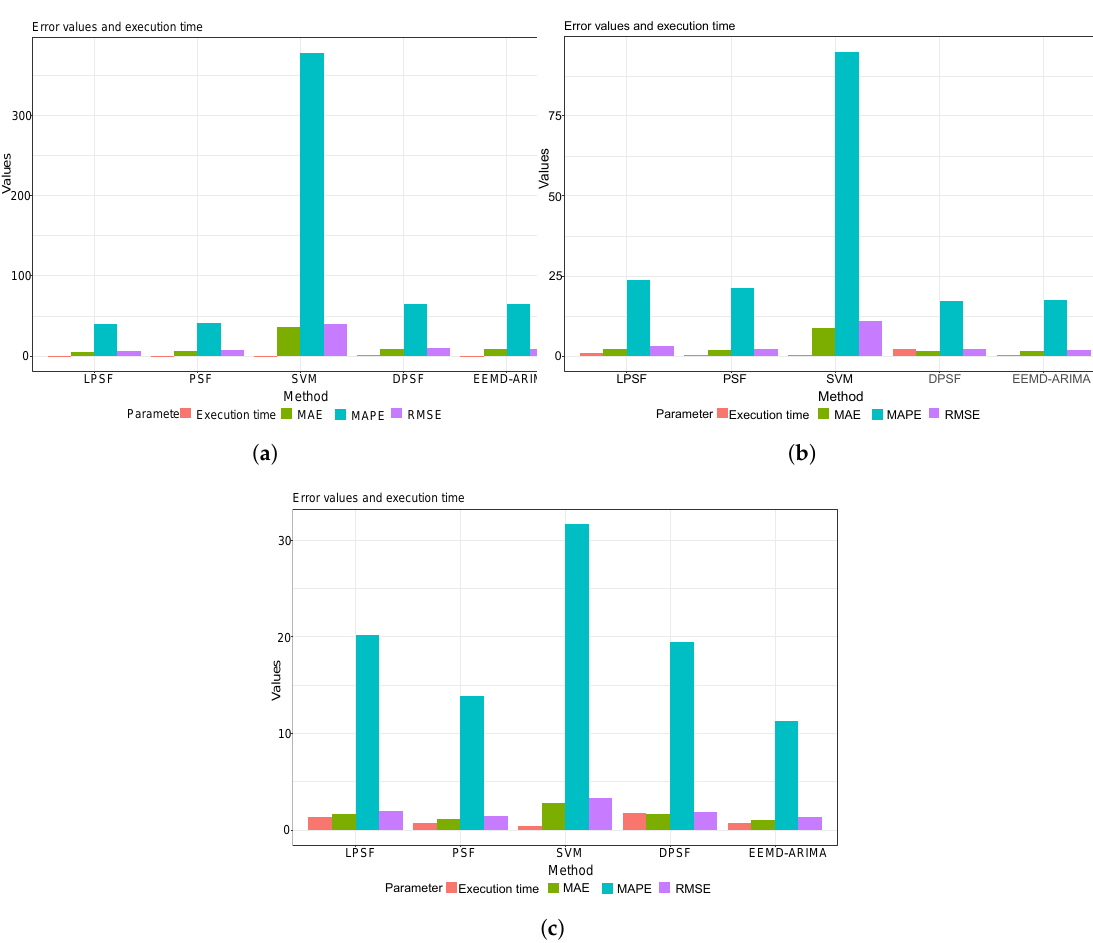
Figure 7. The bar chart of the performance metrics and time execution results of wind speed forecasting for the daily ( a ), weekly ( b ) and monthly ( c ) at Watford City